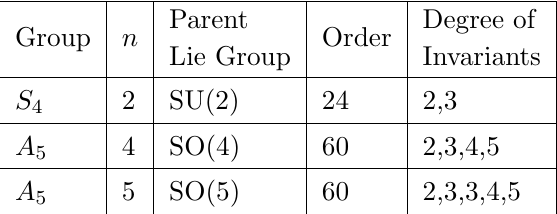
Table 3. Degree of Polynomial invariants for a few other irreps of the familiar groups.